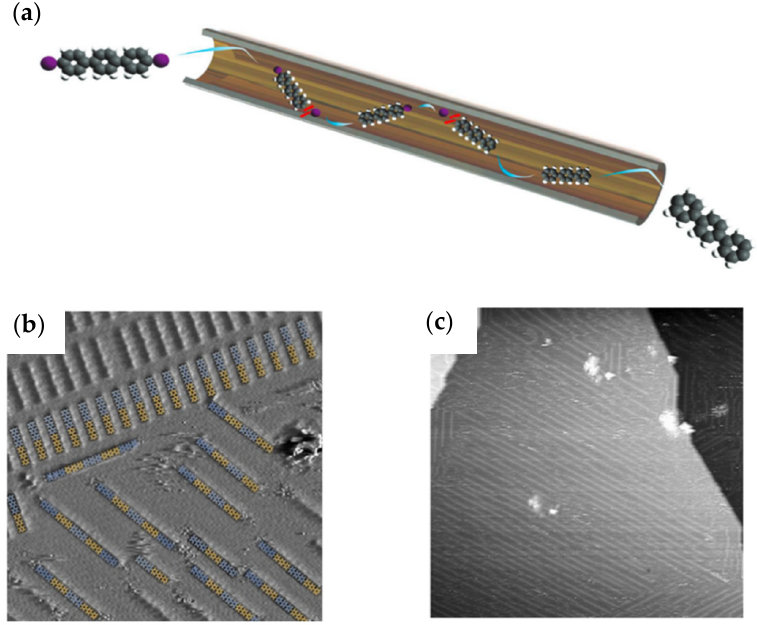
Figure 1. ( a ) Top view of self-assembled fantrip molecules due to π – π interactions. ( b ) 2D covalent network obtained by a [4+4] cycloadditions of adjacent fantrip molecules. ( c ) STM image after deposition of fantrip onto hexacosane-passivated graphite following thermal annealing at 353 K (V s = − 3.2 V, I t = 3 pA, 298K, 22 × 22 nm 2 ). ( d ) STM image obtained after UV-light illumination (V s = − 3.0 V, I t = 3 pA, 298 K, 9 × 9 nm 2 ). The covalently bounded 2D network is constituted mainly by hexagons with a minor presence of pentagons and heptagons (highlighted by white polygons).